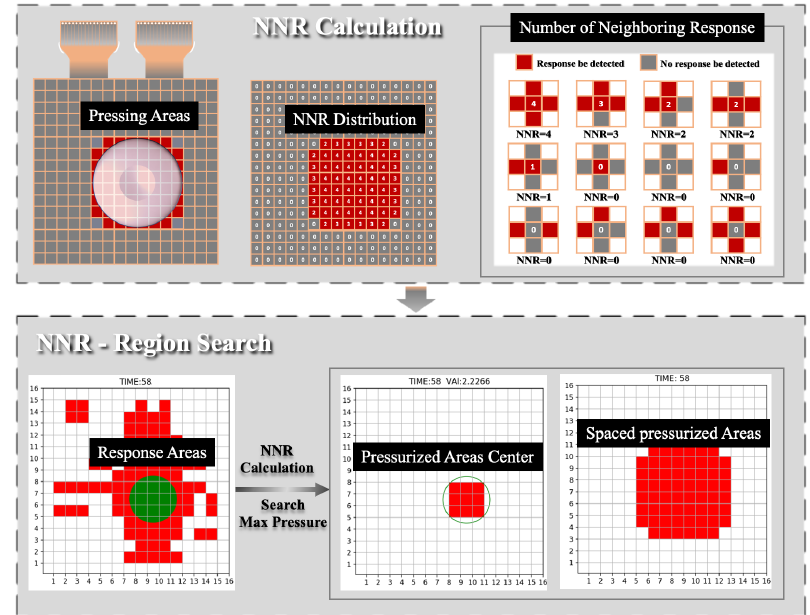
Figure 5. NNR calculation and region search